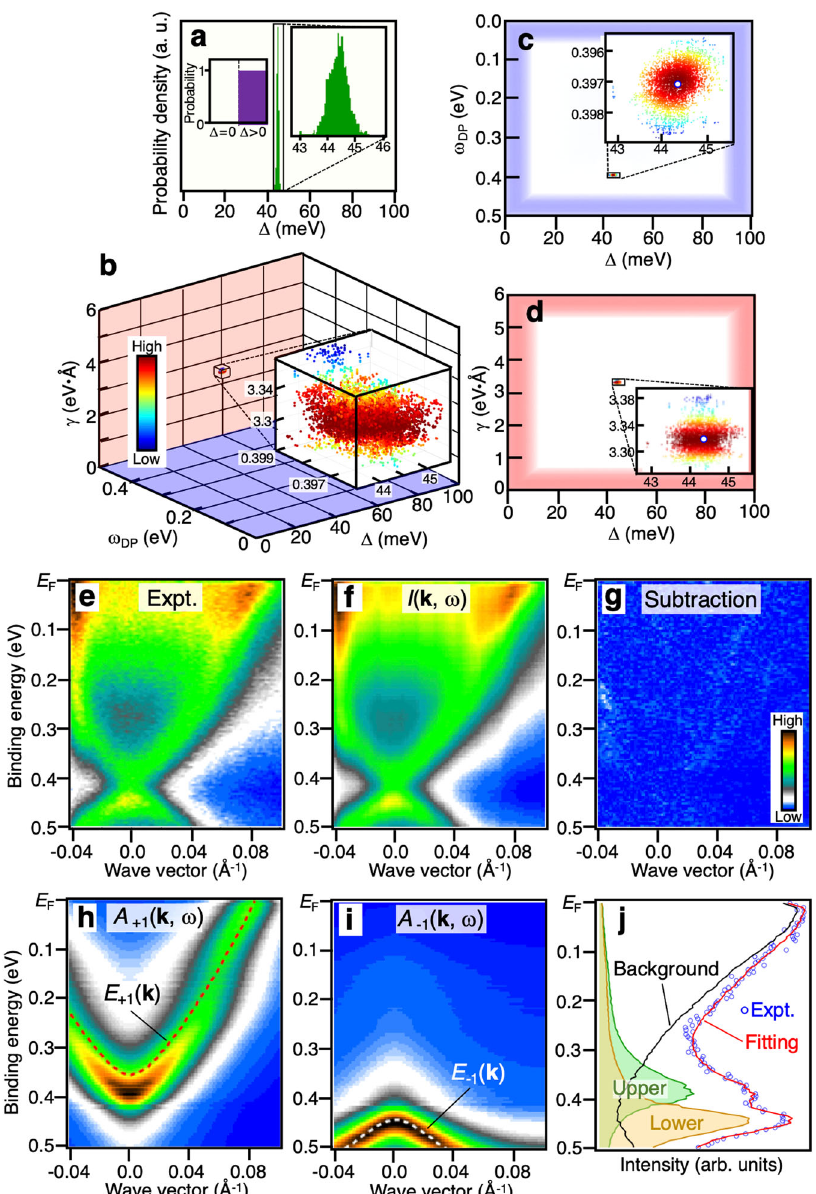
Fig. 3 Extraction of essential band parameters from the semiparametric Bayesian analysis. a Distribution of posterior probability against Δ obtained from the semiparametric fi ttings of the experimental angle-resolved photoemission spectroscopy (ARPES) intensity in Fig. 2a with theoretical ARPES intensity I ( k , ω ). Left inset shows the plot of posterior probability for Δ = 0 and Δ > 0, where Δ denotes half-width of band gap. Right inset shows the magni fi ed view of posterior probability against Δ around the peak. b 3D contour plot of posterior probability as a function of Δ , the binding energy at the Dirac point ω DP , and the Dirac velocity γ . c , d Intensity maps of posterior probability in the ( Δ , ω DP ) and ( Δ , γ ) space, respectively. e ARPES intensity plot of TlBi(S 0.2 Se 0.8 ) 2 (same as Fig. 2a). f Reproduced I ( k , ω ) obtained from the semiparametric fi ttings to the experimental data. g Subtraction of e and f . h , i Extracted single-particle spectral function A s ( k , ω ) for the upper and lower Dirac cones. Bare bands E ±1 ( k ) are indicated by dashed curves. j Experimental EDC at the Γ point (blue open circles) and corresponding simulated EDC (red solid curve), which is decomposed into the upper (green curve) and lower (orange curve) Dirac cones as well as spectral background B ( ω ) (black